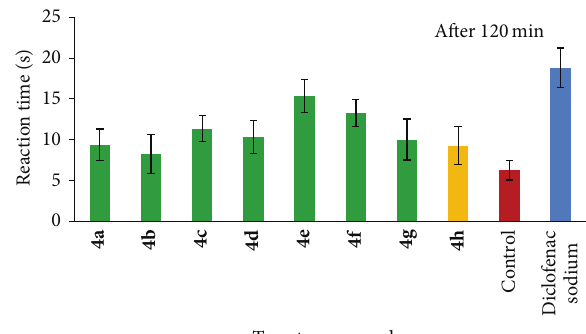
Figure 3: This histogram shows the reaction time in rats by tail immersion method. The histogram is plotted between target compounds ( 4a–h ) at 100mg/kg, control, standard drug Diclofenac sodium (10mg/kg), on X axis, and reaction time (sec) on Y axis. Data showed that the reaction time significantly increases by target compounds from control. Data are Mean ± S.E.M. indicates significant increase in reaction time form control and indicates highly significant increase, 𝑃 < 0.05